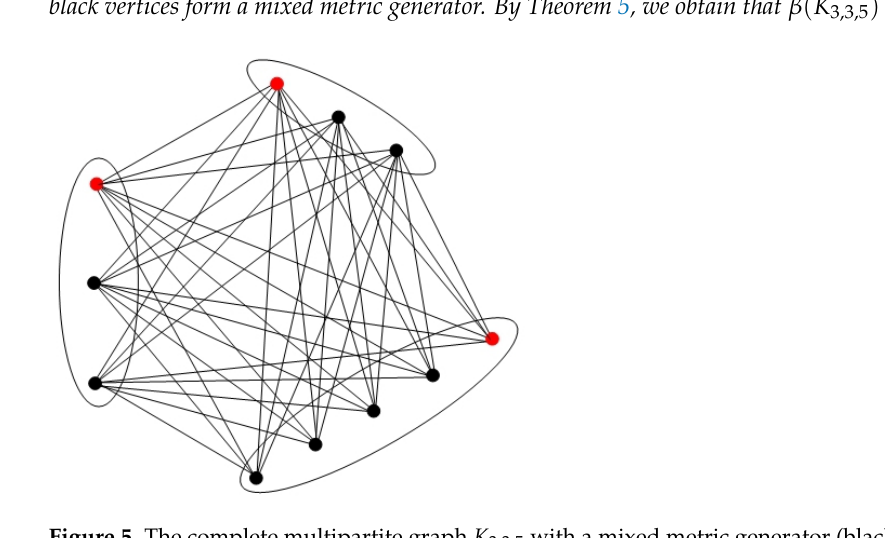
Figure 5. The complete multipartite graph K 3,3,5 with a mixed metric generator (black